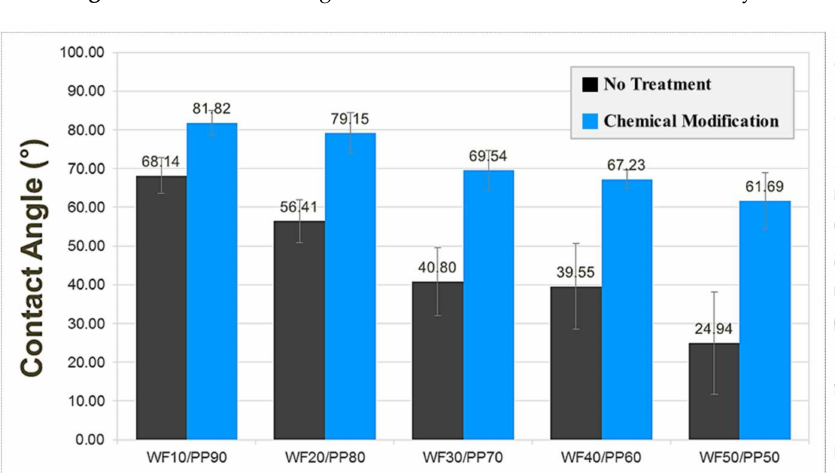
Figure 12. The contact angle measurement method used in this study.